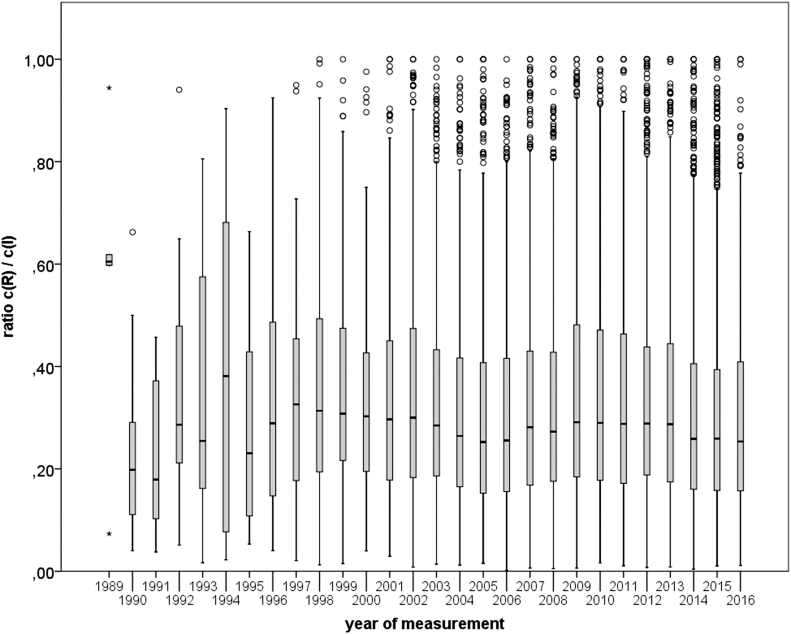
Boxplot of ratios c(R)/c(I) for the years 1989–2016.